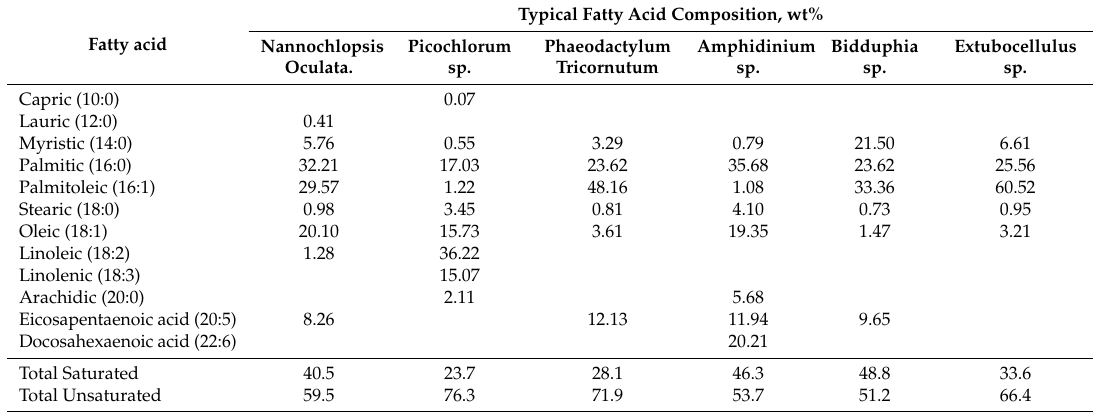
Table 3. Typical fatty acid composition of various microalgae species. Data from [41]. sp.: